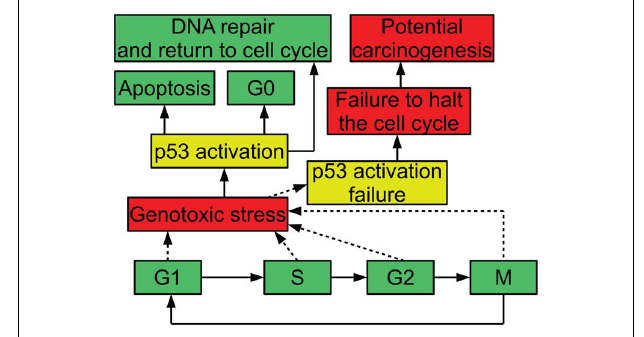
FIGURE 1 | Diagram of p53 and the cell cycle, showing possible outcomes of stress and p53 activation.